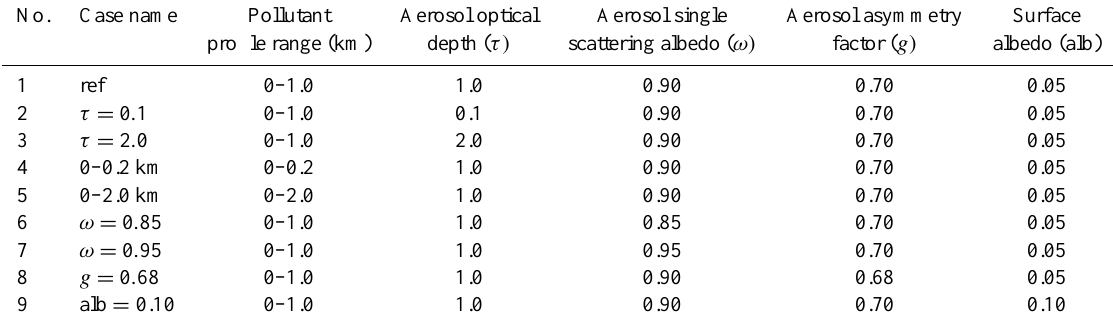
Table 1. Physical parameters used in the AMF